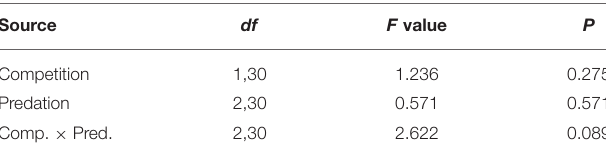
TABLE 4 | ANOVA results for proportion of eclosed adult female Aedes aegypti surviving to take a blood meal. Source df F value P Competition 1,30 1.236 0.275 Predation 2,30 0.571 0.571 Comp. × Pred. 2,30 2.622